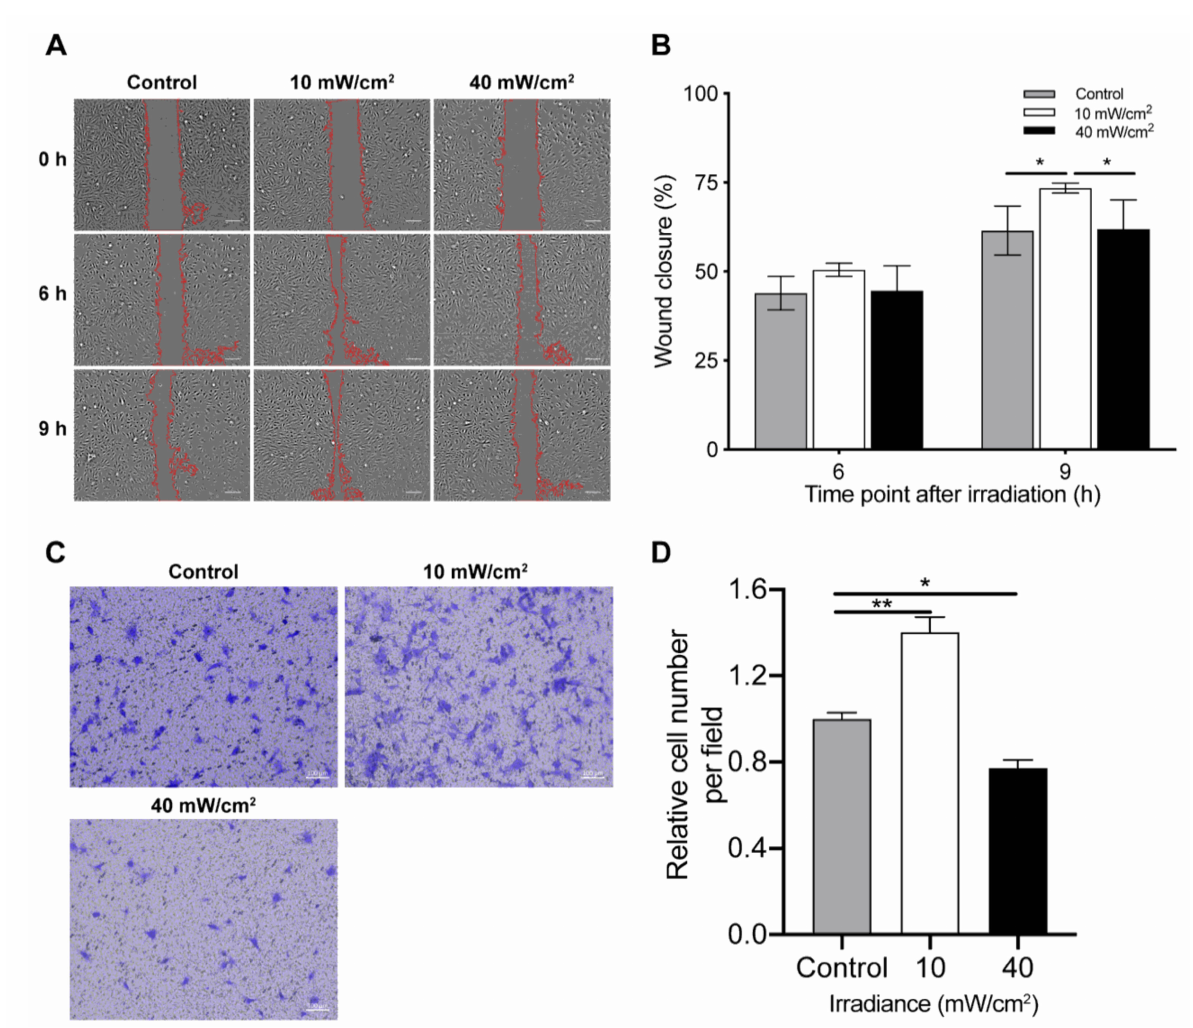
Figure 3. Blue light irradiation affected the cell migration of human umbilical vein endothelial cells (HUVECs): ( A ) Repre- sentative images of the wound healing assay of HUVECs following exposure to either low fluence (10 mW/cm 2 × 12 min) or high fluence (40 mW/cm 2 × 12 min) at 0, 6 and 9 h after irradiation. The scale bar is 100 µ m. ( B ) Quantification of data from wound healing assays. Percentage of wound closure was measured as follows: Wound closure (%) = (original wound area—unhealed wound area)/original wound area) × 100%. Data are shown as mean ± SD ( n = 3 repetitions, * p < 0.05, two-way ANOVA). ( C ) Representative images of the transwell assay of HUVECs following exposure to either low fluence (10 mW/cm 2 × 12 min) or high fluence (40 mW/cm 2 × 12 min) illumination at 6 h after irradiation. The scale bar is 100 µ m. ( D ) Quantification of data from transwell assays. Data are normalized to control groups and shown as mean ± SD ( n = 3 repetitions, * p < 0.05, ** p < 0.01, one-way